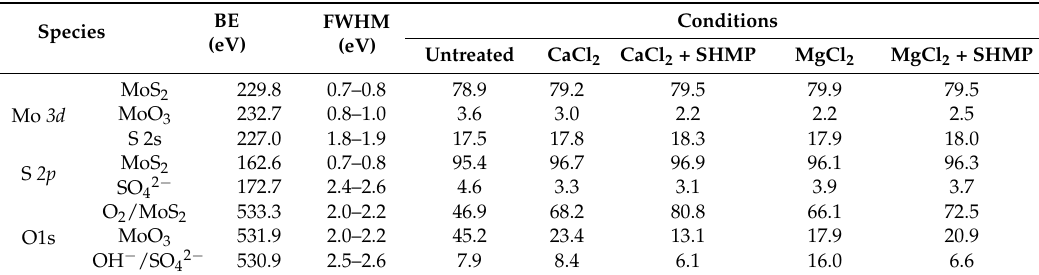
Table 4. Species content (% element) on MoS 2